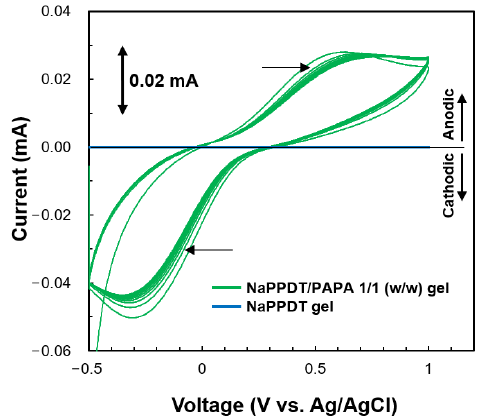
Figure 7. Cyclic voltammograms of hydrogels in 0.1 NaCl aq.: NaPPDT / PAPA 1/1 ( w / w ) composite gel and 1.0 wt% NaPPDT gel (10 oxidation/reduction cycles, scan rate: 0.05 V s − 1 ). The horizontal arrows indicate the direction of movement of the curve as the number of scans increases.